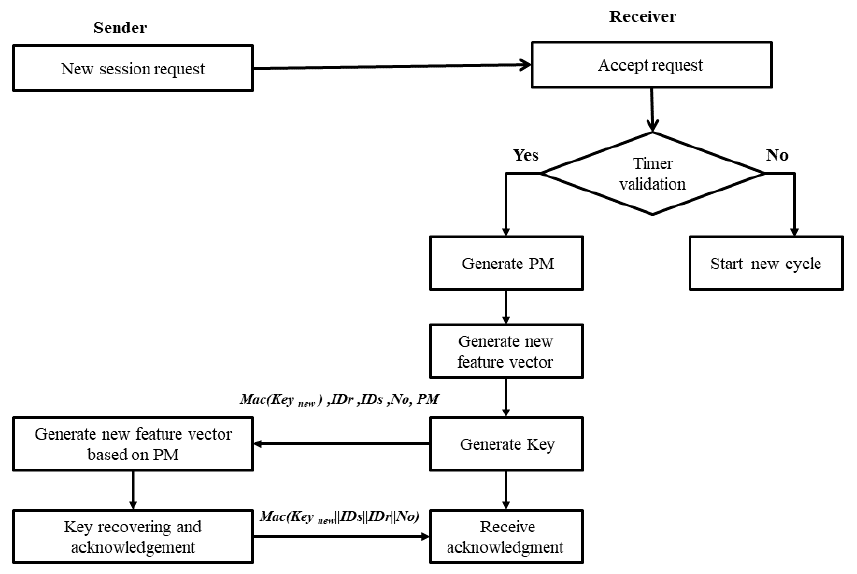
Figure 7. The later connection’s cycle flowchart.